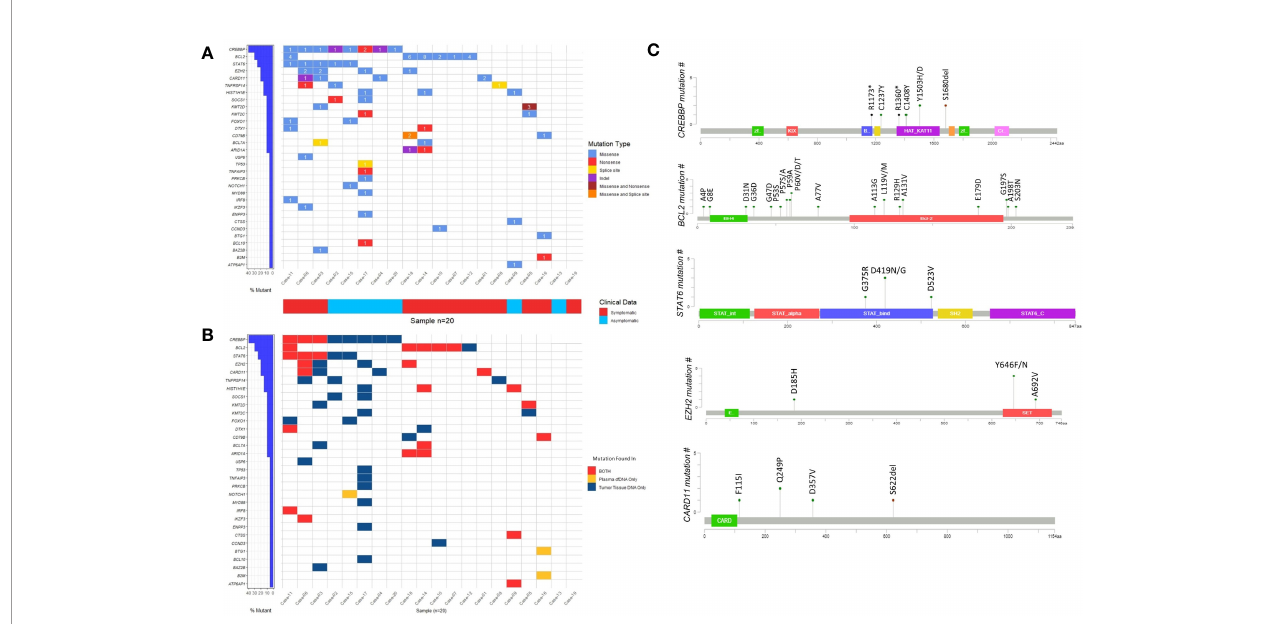
FIGURE 3 | The somatic variants identi fi ed by ultra-deep sequencing in cfDNA and/or tumor tissue DNA FL patients. (A) Waterfall plot showing the genes with missense, nonsense, splice site, and indel mutations detected in FL cases. Number labels indicate the number of mutations found on that gene for that FL case. Horizontal blue bars on the left show the percentage of FL cases mutated for the genes. If a gene displayed as having two mutation types includes three or more mutations in a FL case, it means at least one of these mutations belong to a mutation type different than others. (B) Waterfall plot showing the DNA type mutations found in plasma cfDNA, FFPE tDNA or both. Horizontal blue bars on the left show the percentage of FL cases mutated for the genes. If a gene in a FL case includes more than one mutation that is displayed as present in both DNA types, it means at least one of these mutations is present in both plasma cfDNA and FFPE tumor tissue DNA samples. (C) The domains and affected residues of recurrently mutated genes in FL cases determined with Cbioportal mutation